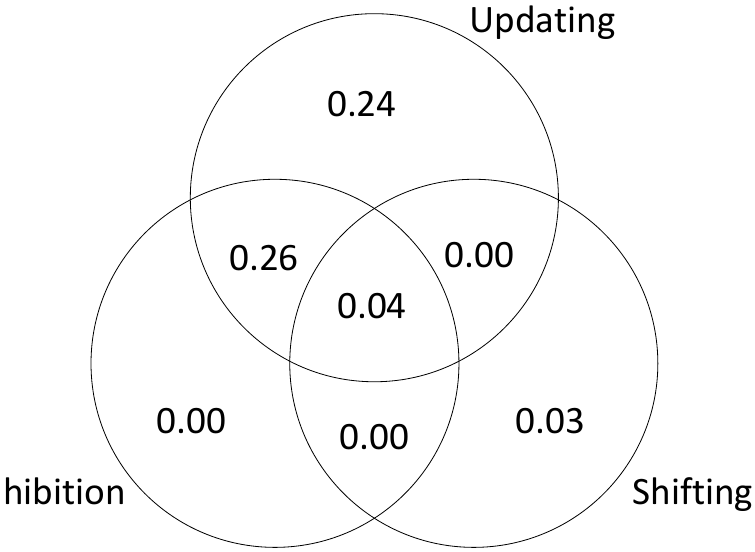
Figure 10. Unique and shared variance in g accounted for by executive functions, Friedman et al. (2011).